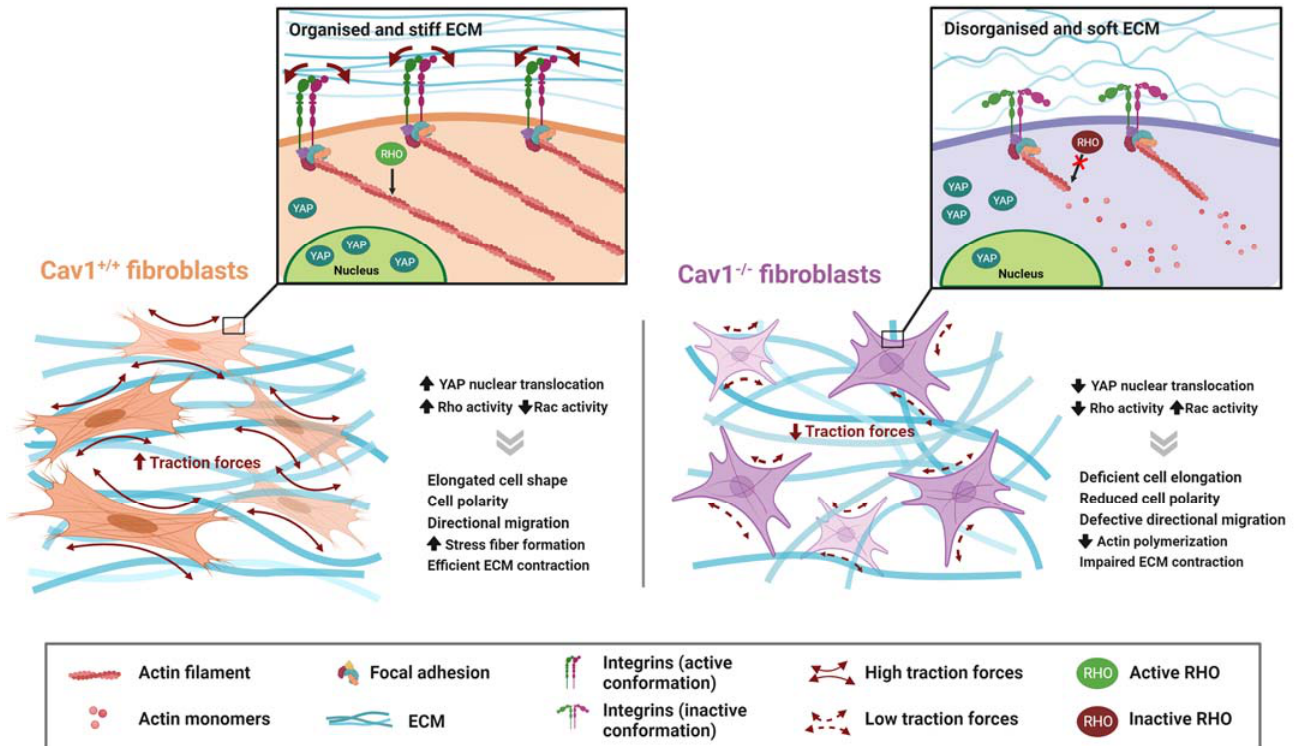
Figure 3. Role of Cav1 in ECM physical remodeling. Stromal cells interact with the ECM, reorganizing it by applying forces at cell–ECM contact sites. In fibroblast, Cav1 promotes actin polymerization and stress fiber formation through Rho activation, and regulates cell polarization and directional migration. In response to substrate stiffness, Cav1 also positively regulates YAP nuclear translocation, which in turn regulates the expression of genes involved in ECM remodeling. Cav1 favors ECM contraction through the exertion of tractional forces by fibroblasts, leading to a more organized and stiffer ECM, while Cav1-depleted fibroblasts generate a disorganized and softer ECM. Created with BioRender.com accessed on 6 March 2023.